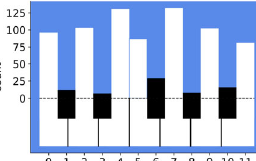
Fig. 2 Schematic diagram of the pitch-class counts of an example musical piece in C major. A pitch class is a set of notes which are related by multiplicities of octaves (0 represents C, 5 represents F, etc.). The diagram shows for each pitch class the sum of how often the pitches of this class appear in the piece. In this paper, musical pieces are represented by the vectors of their pitch-class counts weighted by duration. This abstraction from the order in which the notes appear in the piece is similar to the bag- of-words model used in Natural Language Processing.